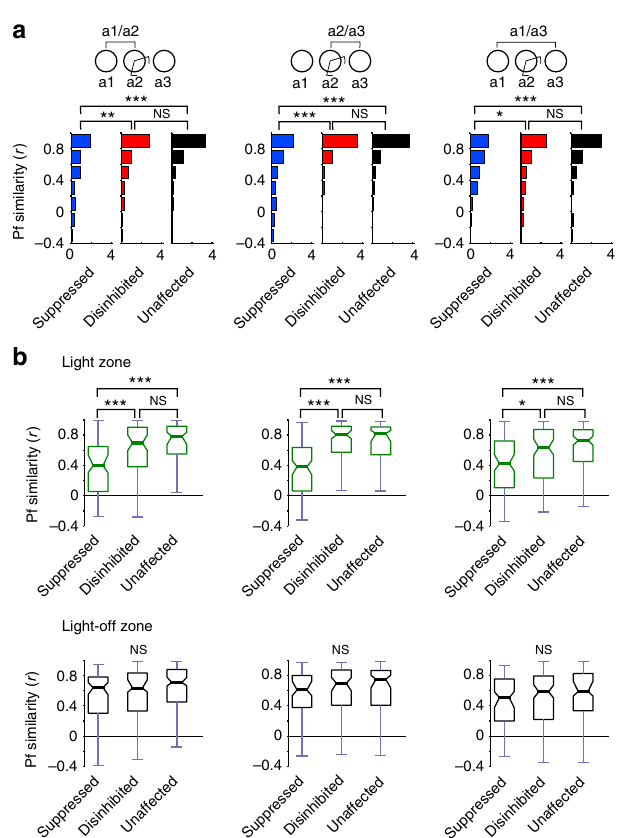
Figure 3 | Suppression of CA1 place cell activity leads to sustained reorganization of place fields specifically in the light zone (familiar paradigm). ( a ) Distribution of PFS between exploration sessions for different light-response categories using the entire arena. Suppressed, disinhibited, unaffected Kolmogorov–Smirnov test, a1/a2, suppressed–disinhibited: